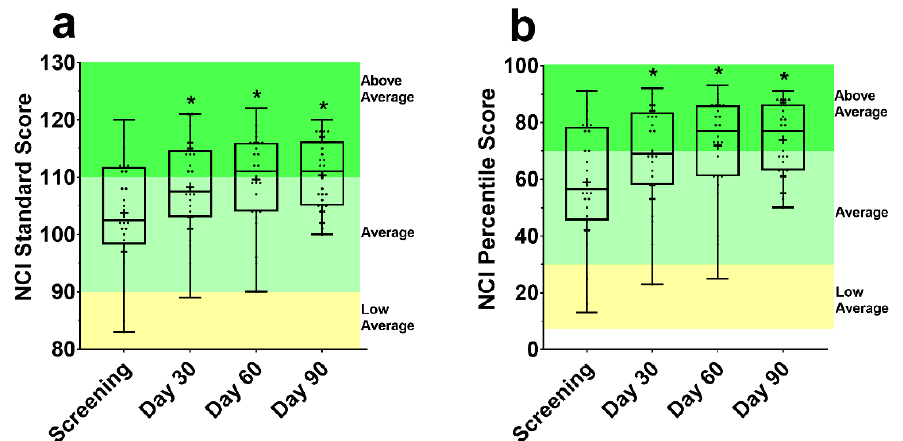
Figure 2. Standard ( a ) and percentile ( b ) scores for the CNS Vital Signs (VS) Neurocognitive Index (NCI). Each box is made up of the 25th, 50th, and 75th quartile with the whiskers extending to the minimum and maximum value. Dots are individual data points, and the cross is the mean. Above average, average, and low average classification from CNS-VS Interpretation Guide [44]. NCI score CNS-VS panel was assessed using a repeated measures mixed effects model with visit number as the fixed effect and participant as the random effect. * Significantly different from screening ( p < 0.05).